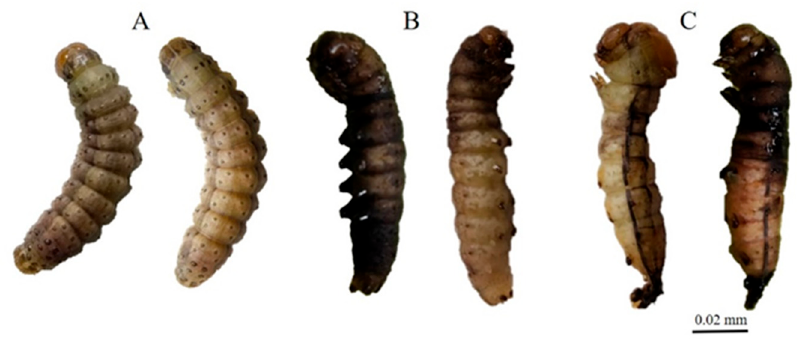
Figure 2. ( A ) Control 5th instar larvae; ( B , C ) Malformed 5th instar larvae.